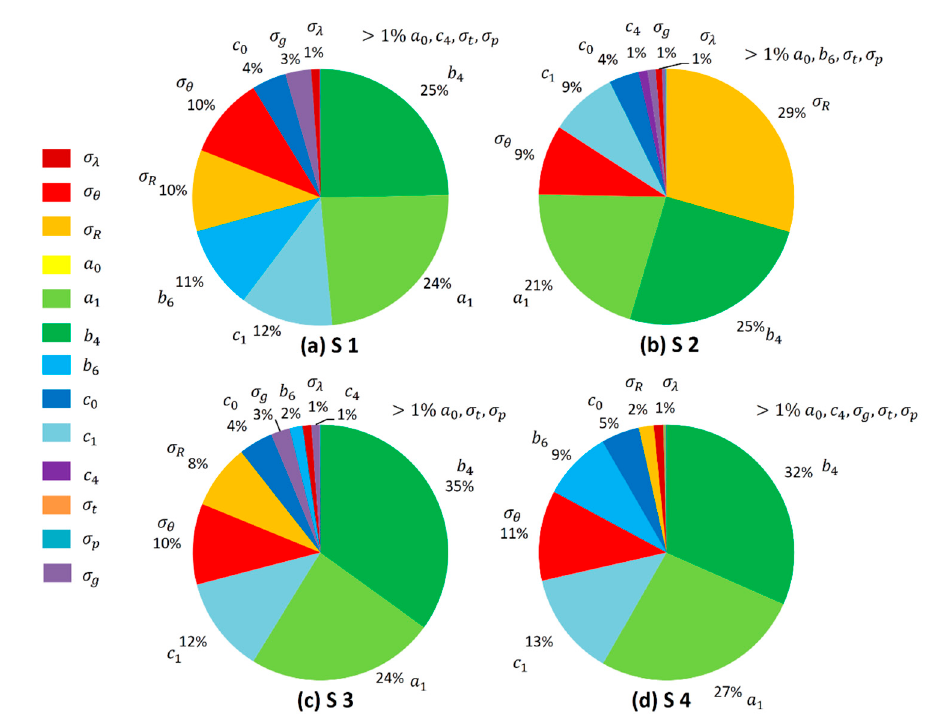
Figure 8. The contribution of variances for instrumental and atmospheric elementary errors in percent for ( a ) S1, ( b ) S2, ( c ) S3, ( d ) S4. For parameter names, see Sections 3.2 and 3.4.